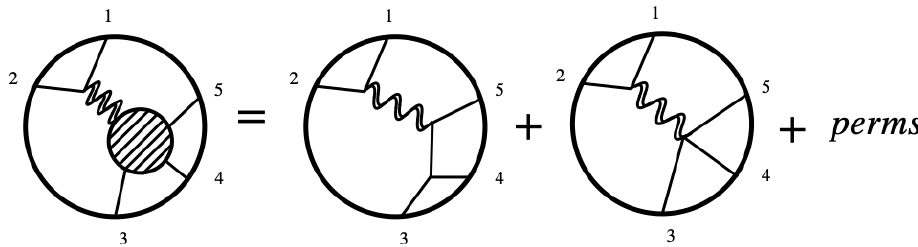
Figure 5. Factorization on an internal graviton line. Here \ perms " denotes the other inequivalent diagrams obtained by permuting the external legs 3, 4 and 5. Upon factorizing the (cid:12)ve-point function on the internal graviton line, we obtain a three-point function hO 20 0 O 20 0 T (cid:22)(cid:23) i and a four- point function hT (cid:22)(cid:23) O 20 0 O 20 0 O 20 0 i